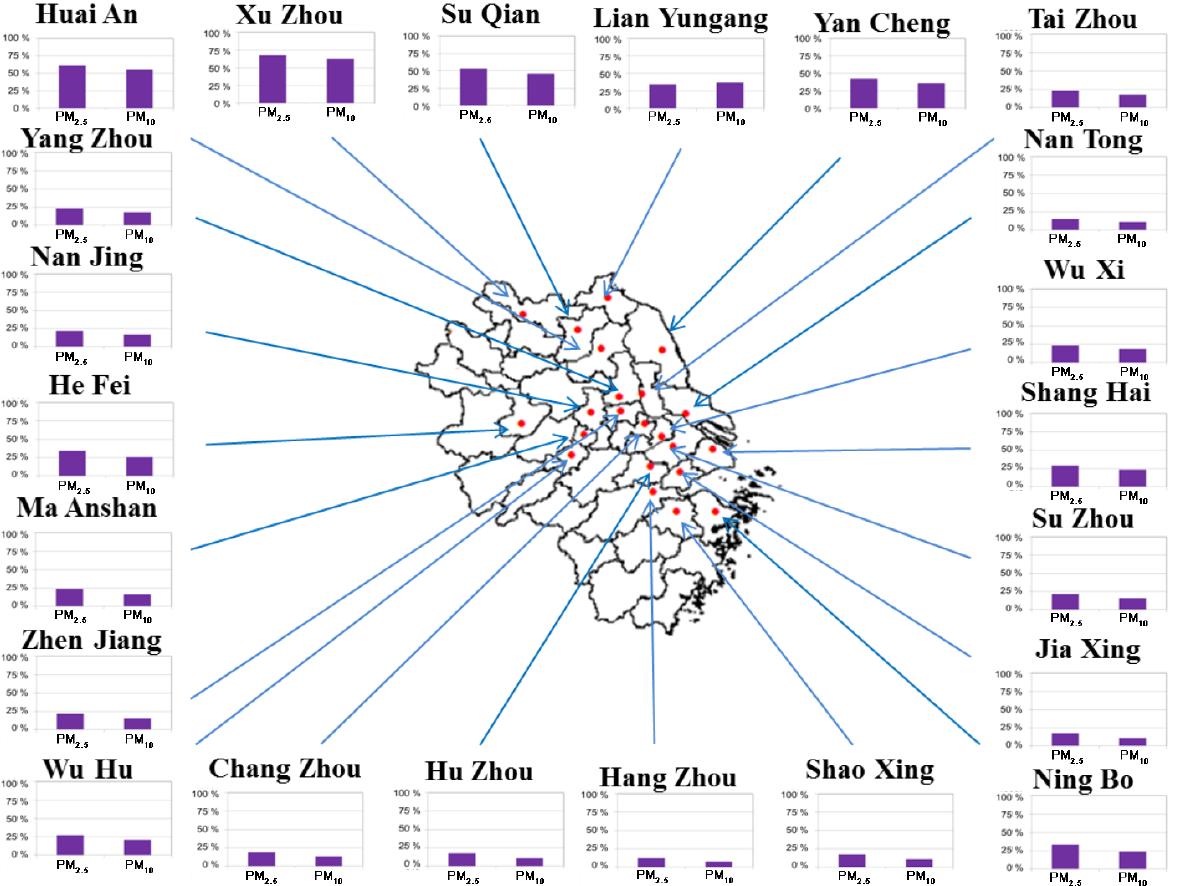
Figure 9. The contribution of OBB to PM 2 . 5 and PM 10 concentrations for different YRD cities during the OBB event in June 2014.